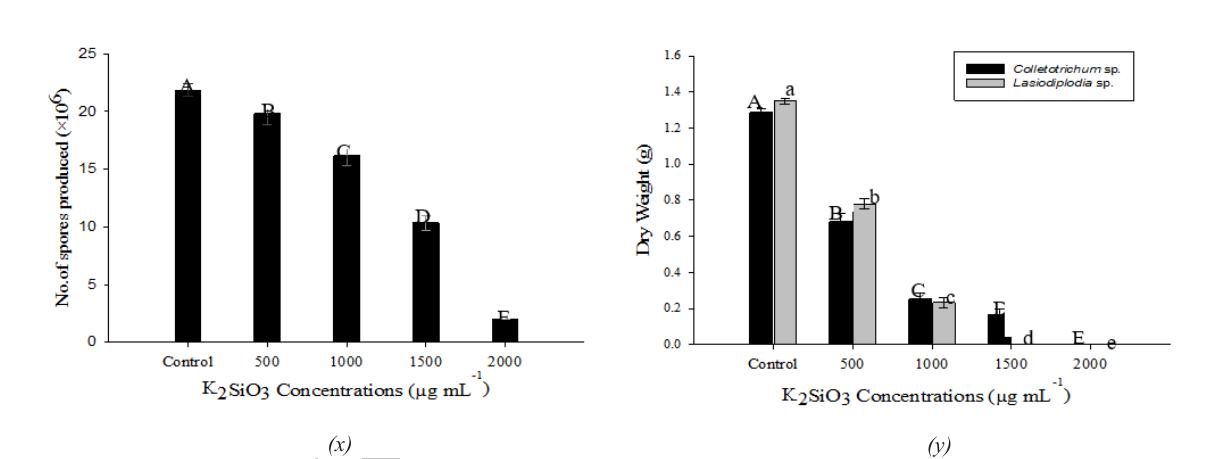
Figure 2: ( x ) Mean number of spores of Colletotrichum sp. after seven days of incubation in PDB amended with different concentrations of K SiO . ( y ) Mean mycelial dry weights of Colletotrichum sp. and Lasiodiplodia sp. after seven days of 2 3 incubation in PDB media amended with different concentrations of K difference at p < 0.05. Vertical line in each bar indicates standard error of